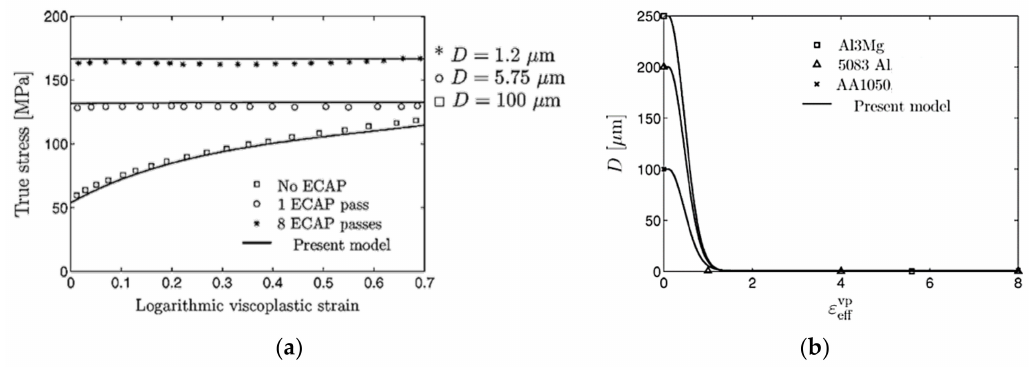
Figure19. Comparisonofpredictedstress–straincurvesandgrainsizesusingthesemi-dislocation-based modellingmethod, withexperimentalresults. ( a )Stress–straincurvesforAA1050afterdi ff erentnumbers of ECAP passes. ( b ) Evolution of grain size, D , for di ff erent Al alloys. Symbols represent experimental results while solid lines represent computed results (Reproduced with permission from Elsevier